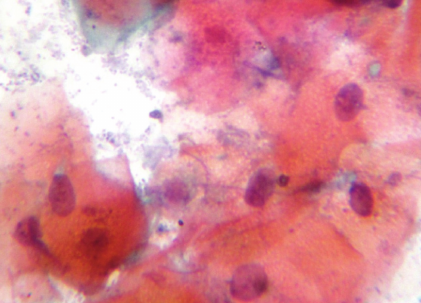
Figure 4: Photomicrograph showing epithelial cells clumping of chromatin within the nucleus (40x).